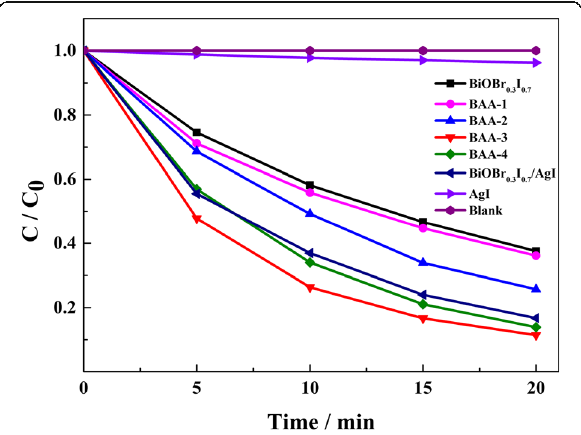
Fig. 4 Photocatalytic activities of MO degradation presented by different